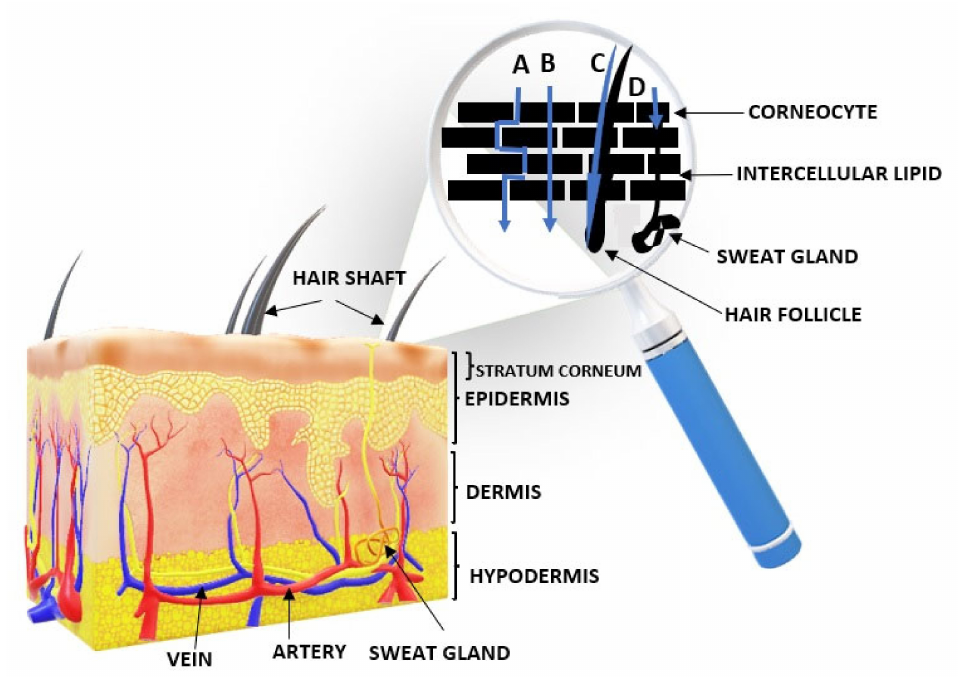
Figure 2. Structure of the skin. Routes of drug permeation across the stratum corneum: A—intercellular penetration pathway; B—transcellular penetration pathway; C—transfollicular drug delivery; D—transglandular drug